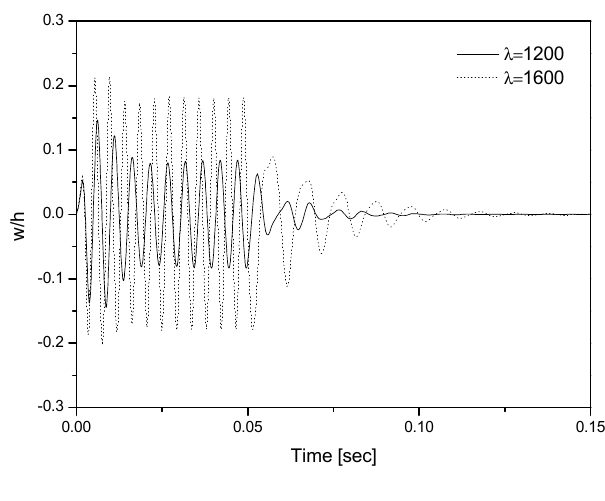
Figure 10. Flutter suppression behaviors under thermal and aerodynamic loads.